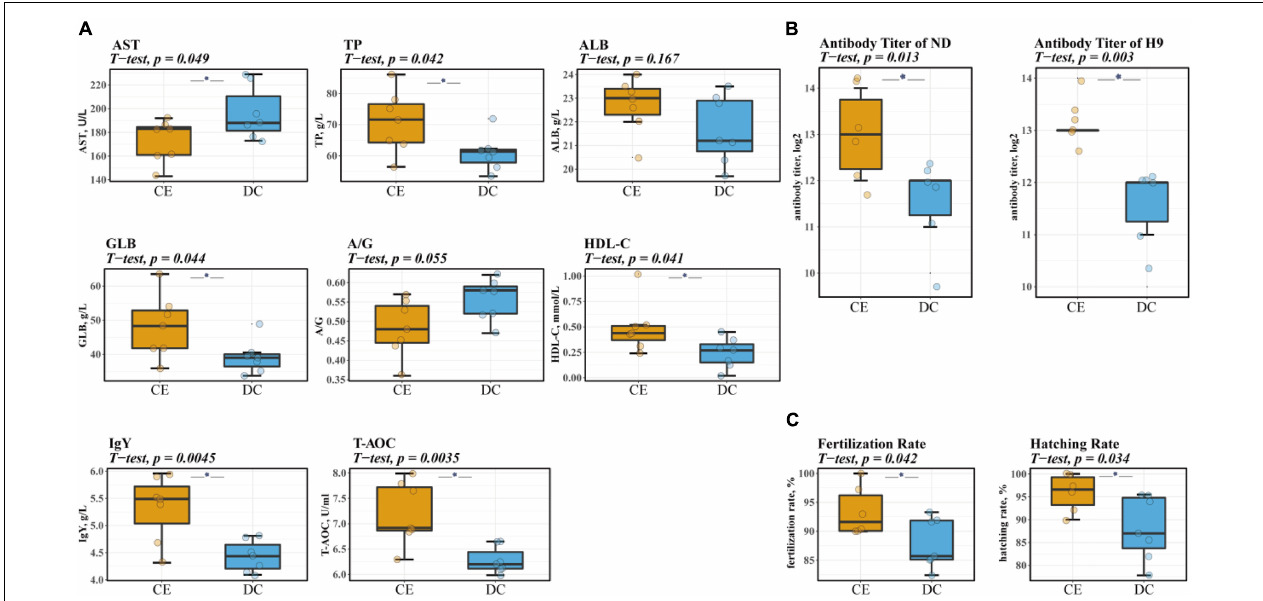
FIGURE 1 | CE can increase the level of serum immunity, antioxidant, and liver-related indicators and significantly improve breeding hens’ reproduction performance ( n = 7 hens/group). (A) The levels of biochemical parameters of breeding hens. (B) Serum antibody titers of NDV and avian influenza H9 strain of breeding hens. (C) The reproduction performance efficiency of breeding hens. Left: representative fertilized eggs rate; Right: representative the hatching of fertile (HoF) rate. ALB, Albumin; AST, Aspartate Aminotransferase; GLB, Globulin; HDL-C, High-density lipoprotein cholesterol; IgY, Immunoglobulin Y; ND, Newcastle disease. T-AOC, Total Antioxidant Capacity; TP, Total protein. * P < 0.05 compared to two groups.